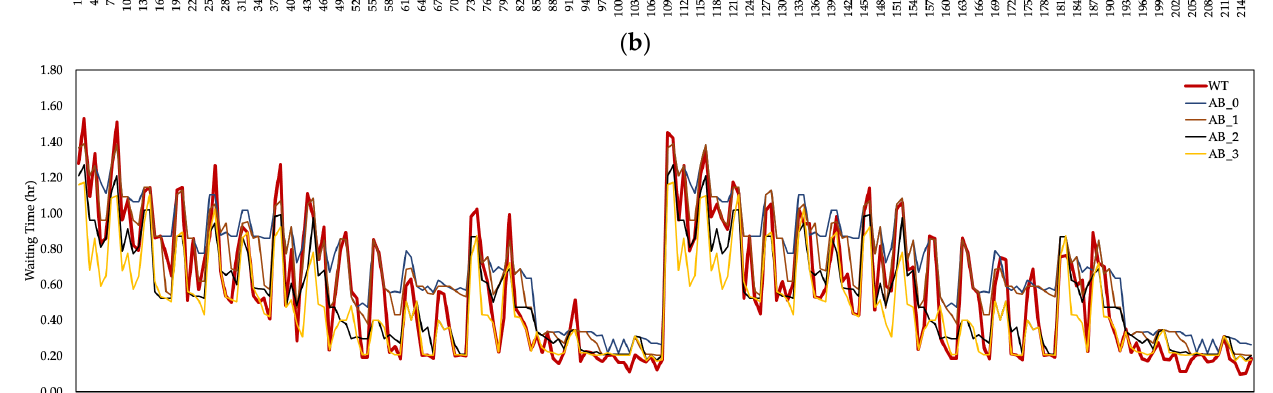
Figure 7. The value of w t based on the ( a ) RF algorithm ( δ 0.0 for RF − 0 , δ 0.1 for RF − 1 , δ 0.2 for RF − 2 for RF − 3 ), ( b ) GB algorithm ( δ 0.0 for GB − 0 , δ 0.1 for GB − 1 , δ 0.2 for GB − 2 , δ 0.3 for GB − 3 ) ( c ) AB algorithm 𝑤𝑤 𝑛𝑛 ( δ 0.0 for AB − 0 , δ 0.1 for AB − 1 , δ 0.2 for AB − 2 , δ 0.3 for AB − 3